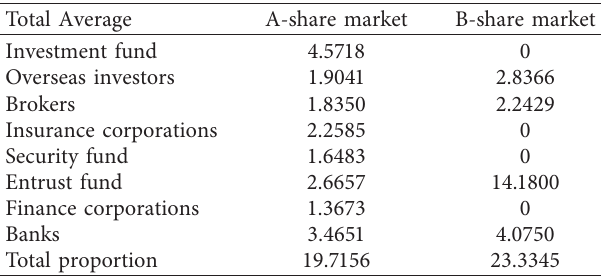
Table 10: Institutional investors in the A-share and B-share